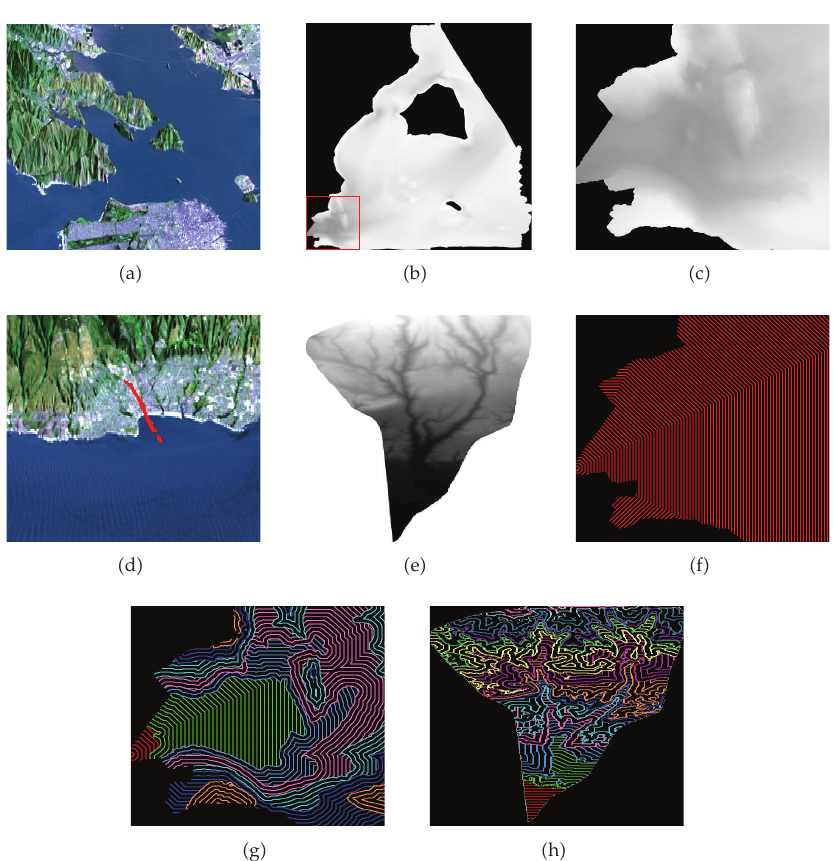
Figure 8: (cid:2) a (cid:3) 3D view of remote sensing data of Central San Francisco Bay, (cid:2) b (cid:3) bathymetry of Central San Francisco Bay, (cid:2) c (cid:3) bathymetry of inset of (cid:2) c (cid:3) , (cid:2) d (cid:3) 3D view of Santa Cruz, and (cid:2) e (cid:3) Digital elevation map of Santa Cruz, (cid:2) f (cid:3) flow field simulated on San Francisco Bay without considering bathymetry, (cid:2) g (cid:3) flow field simulated on San Francisco Bay bathymetry by using octagon, and (cid:2) h (cid:3) flow field simulated on Santa Cruz DEM by using octagon structuring